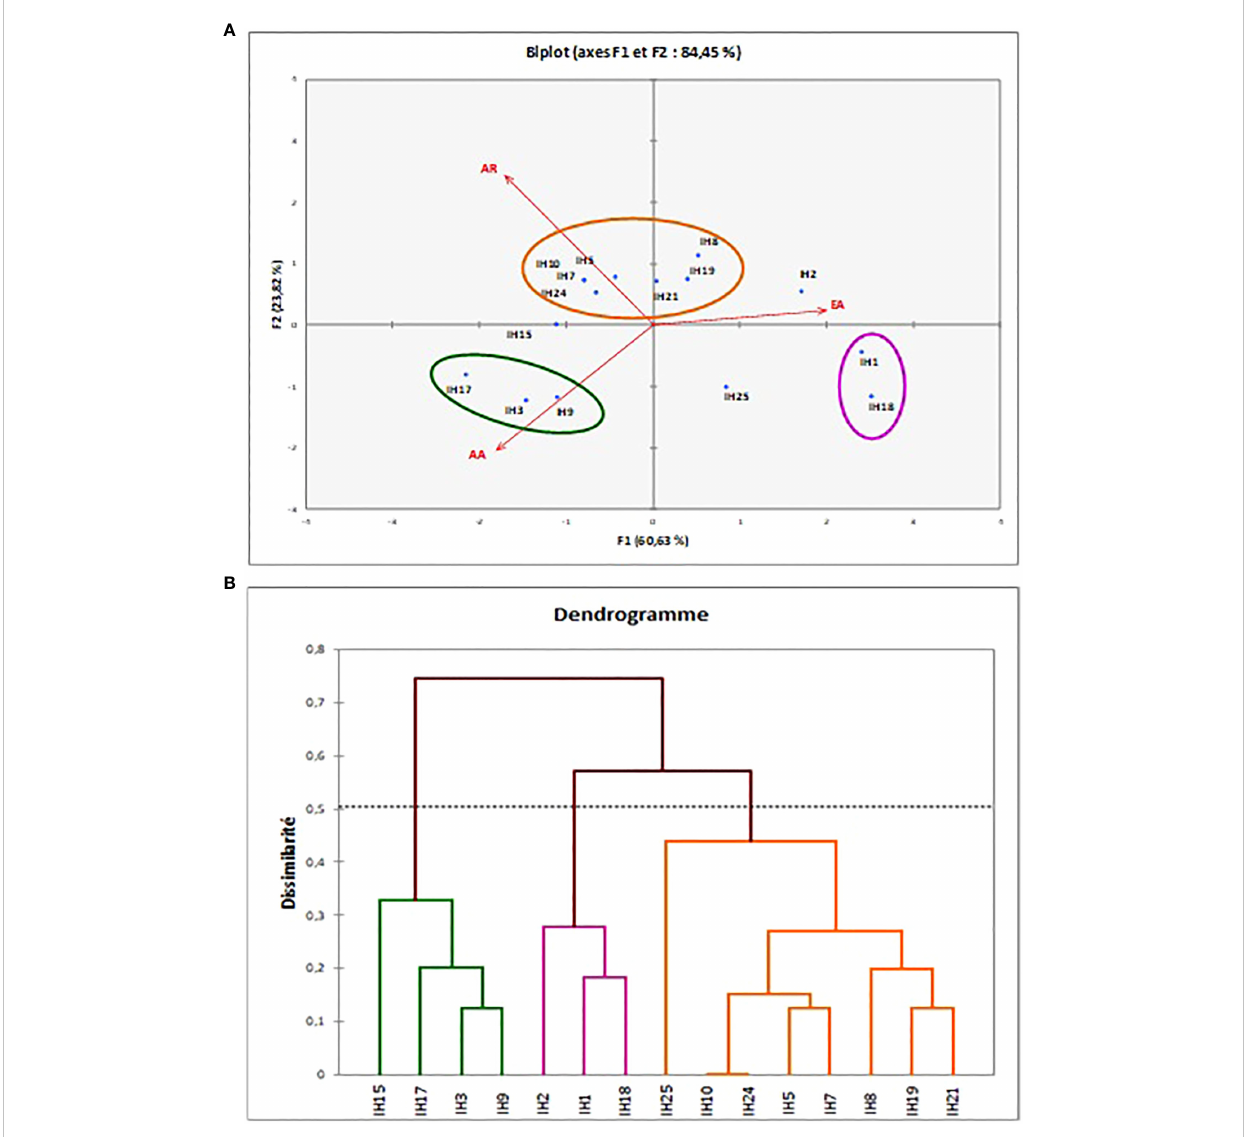
FIGURE 4 Different clusters obtained for the enzymatic, antimicrobial, and antibiotic resistance tests of Ulva ohnoi -associated bacteria strains obtained by PCA (A) and dissimilarity tree (B)